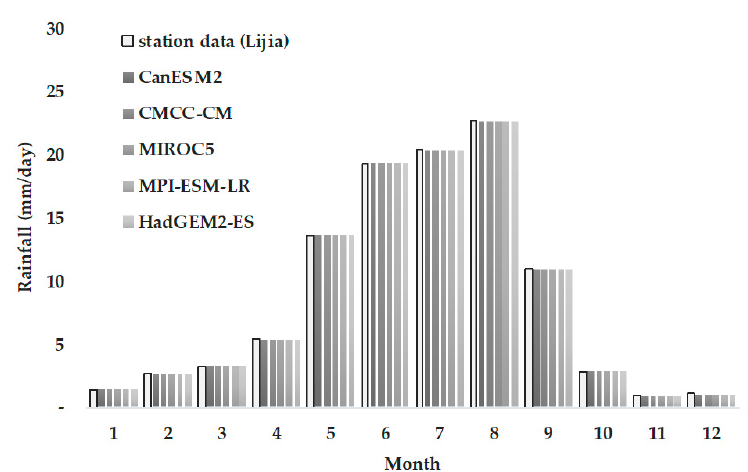
Figure 10. Bias correction result in rainfall of the Optimized-Threshold method.